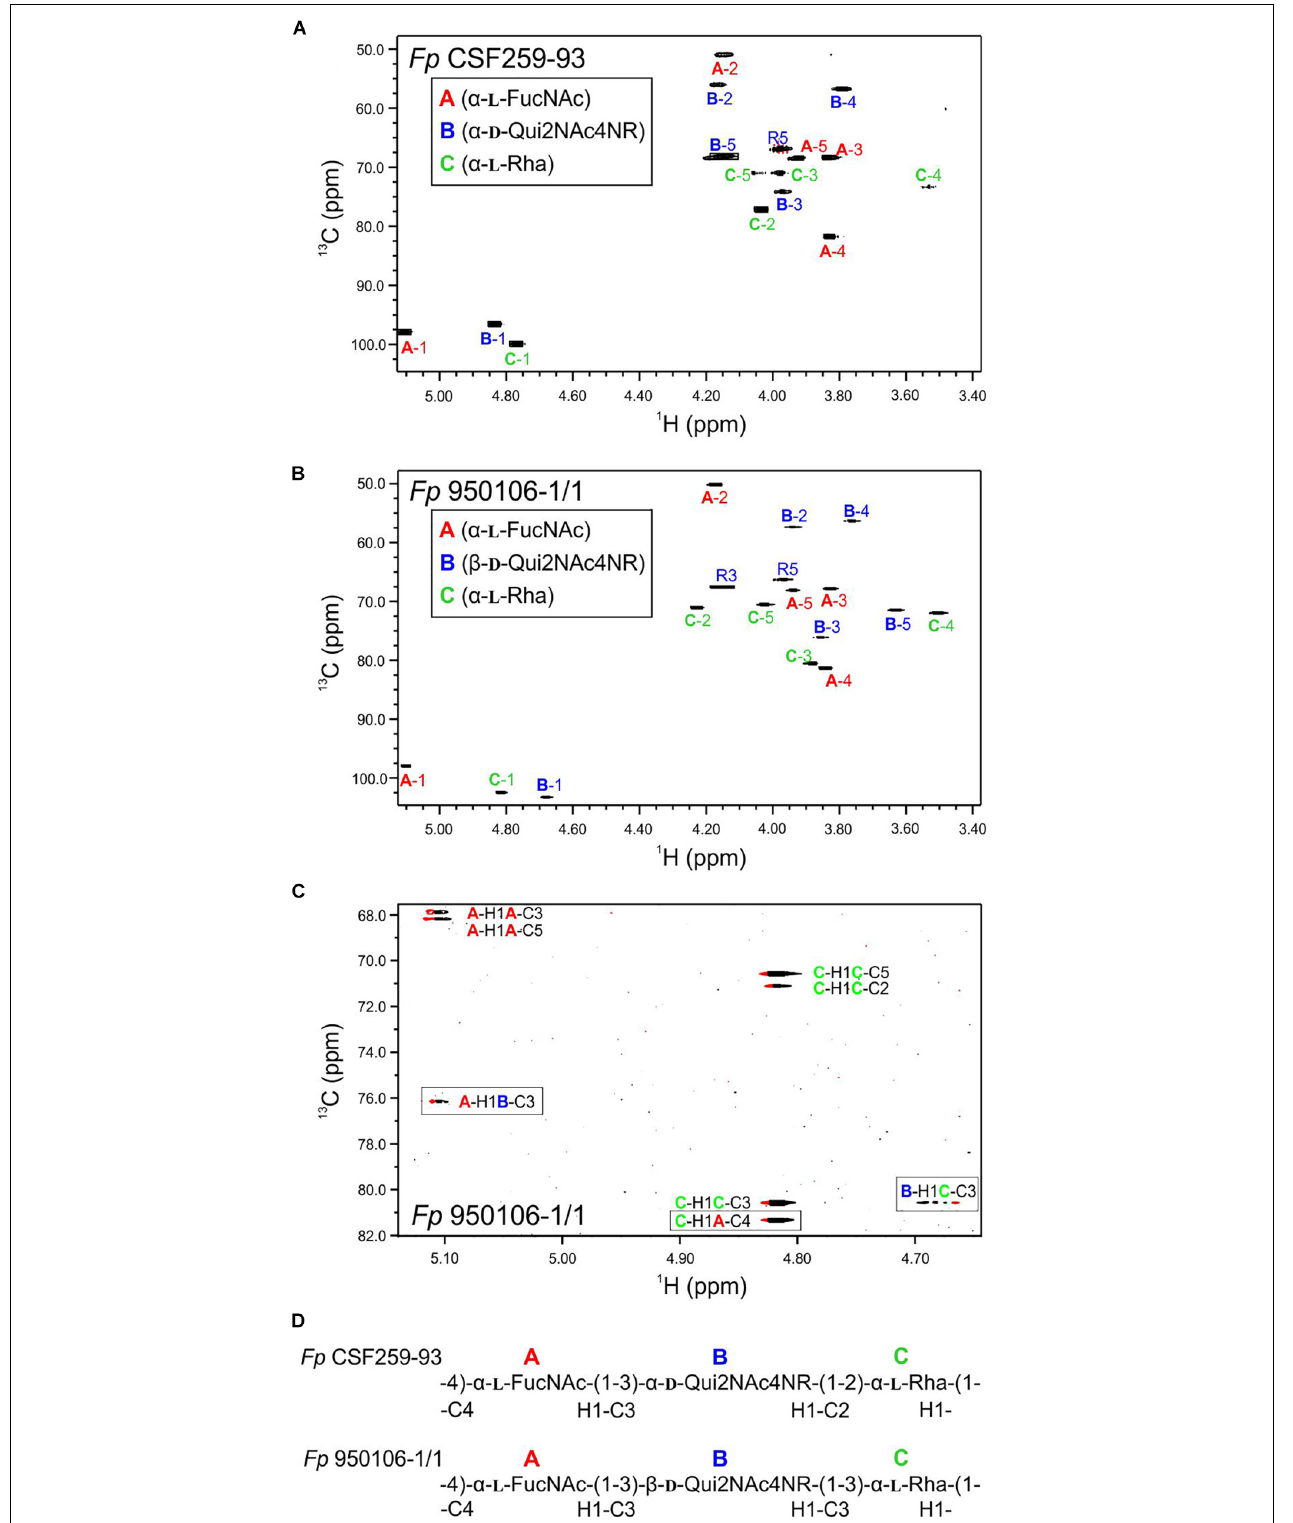
FIGURE 1 | Multiplicity edited 1 H- 13 C HSQC spectra recorded at 55 ◦ C: (A) Fp CSF259-93 O-PS; (B) Fp 950106-1/1 O-PS. (C) Phase-sensitive HSQMBC spectrum of Fp 950106-1/1 O-PS showing both intra- and inter-residue 1 H- 13 C cross peaks; inter-residue cross peaks are identified by rectangles. (D) Structure of each O-PS deduced from 1 H- 13 C HSQC and HMBC or phase-sensitive HSQMBC spectra.